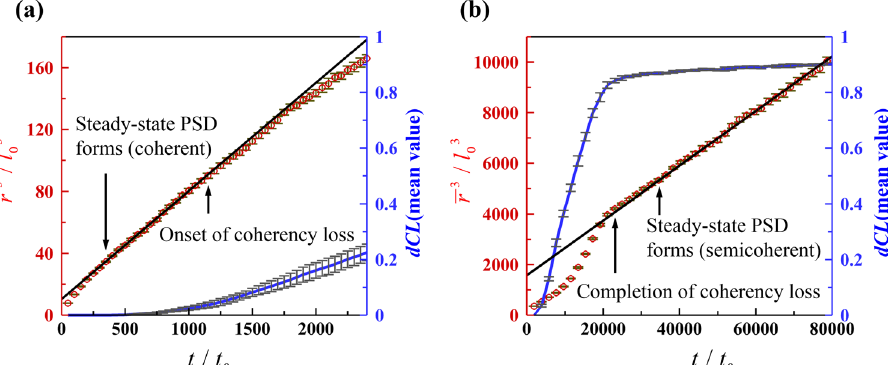
Fig. 5 Simulation of coherency loss at two length scales, respectively. a Using l 0 ’ = 0.5 l 0 focusing on the transition from coherent to semi- coherent (onset of CL), and b l 0 ’ = 2.0 l 0 , focusing on the completion of the CL. The error bars are set similar to Fig.